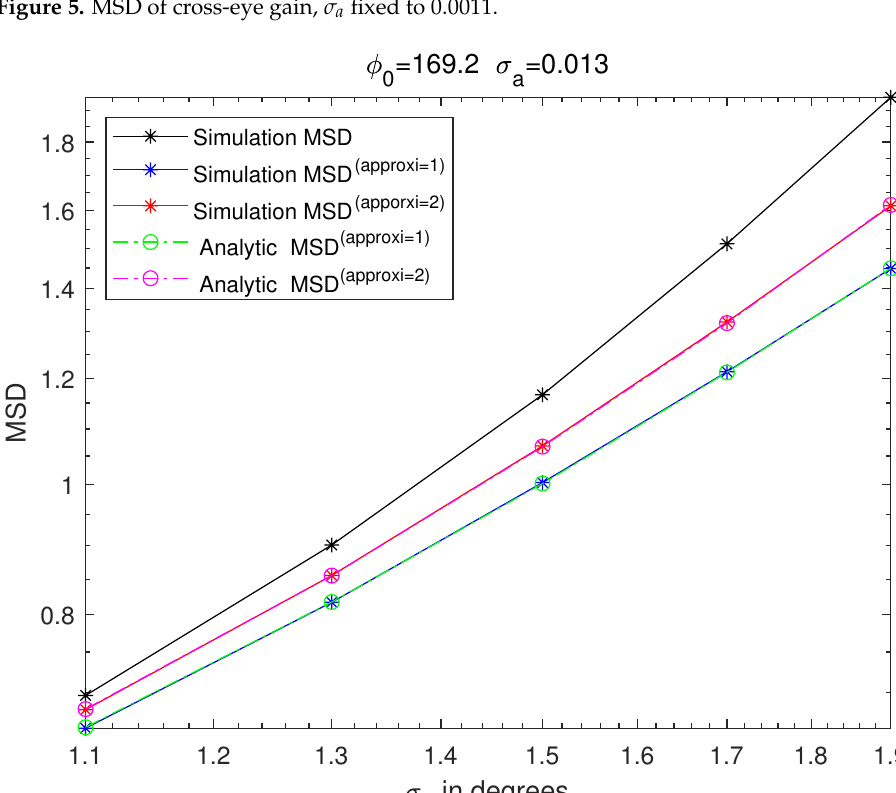
Figure 5. MSD of cross-eye gain, σ a fixed to 0.0011.